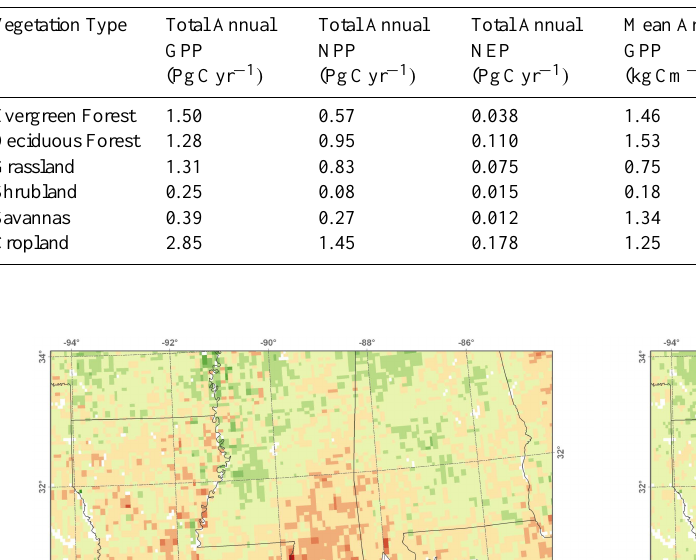
Table 8. TEM estimated annual carbon fluxes for each vegetation type in the conterminous United States during 2000–2005.